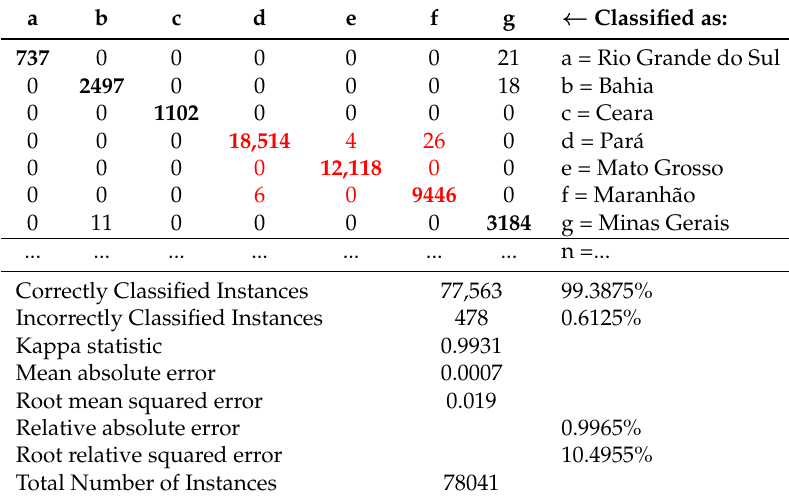
Table 2. Error Matrix for State Classification in the testing